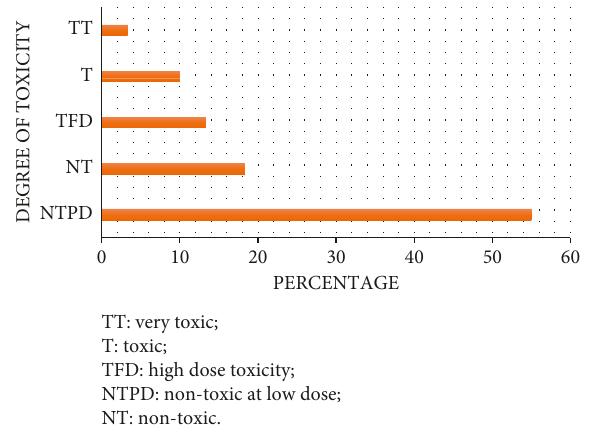
Figure 4: Distribution of medicinal species according to their degree of toxicity. TT: very toxic; T: toxic; TFD: high-dose toxicity; NTPD: nontoxic at low dose; NT: nontoxic.